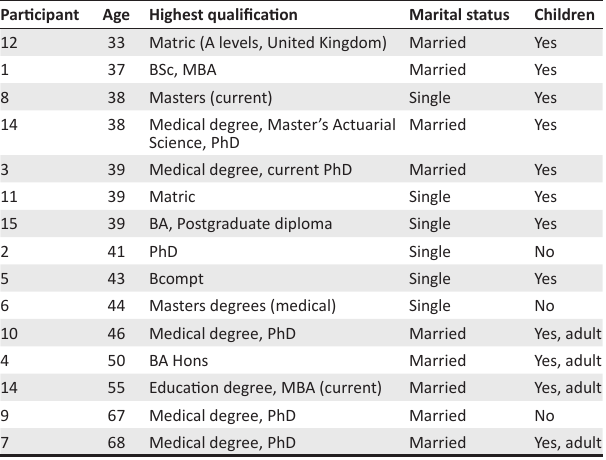
TABLE 1: Descriptive overview of